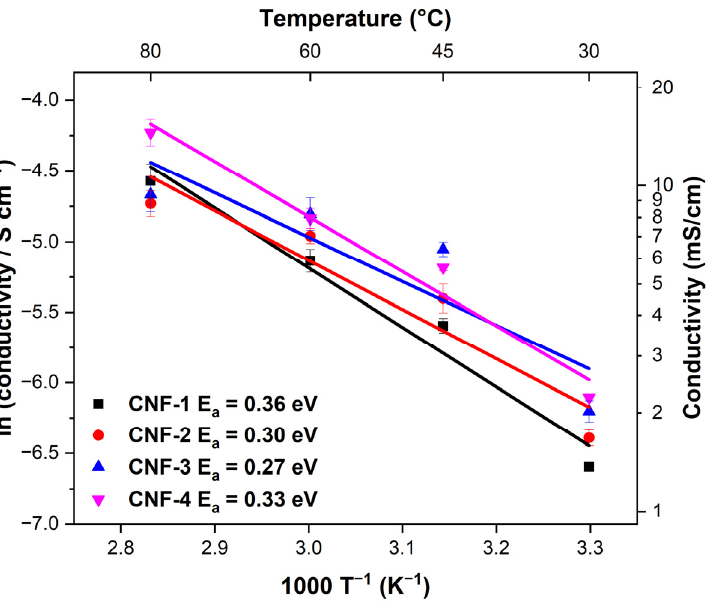
Figure 12. Arrhenius plots and activation energies of CNFs at 100% RH. Table 2. Comparison of maximum power density of CNF-3 with cellulose-based PEM in previous literature. [36,42,45,48].